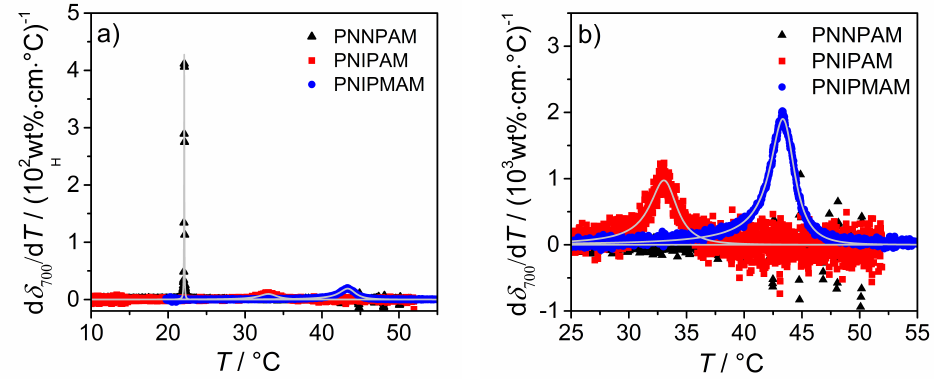
Figure 10. Analysis of the phase transition of PNNPAM, PNIPAM and PNIPMAM microgels using UV/Vis spectroscopy. ( a ) first derivative of the light attenuation coefficients with respect to temperature as a function of temperature; ( b ) detailed image of the temperature range between 25 ◦ C and 55 ◦ C relevant for PNIPAM and PNIPMAM particles.